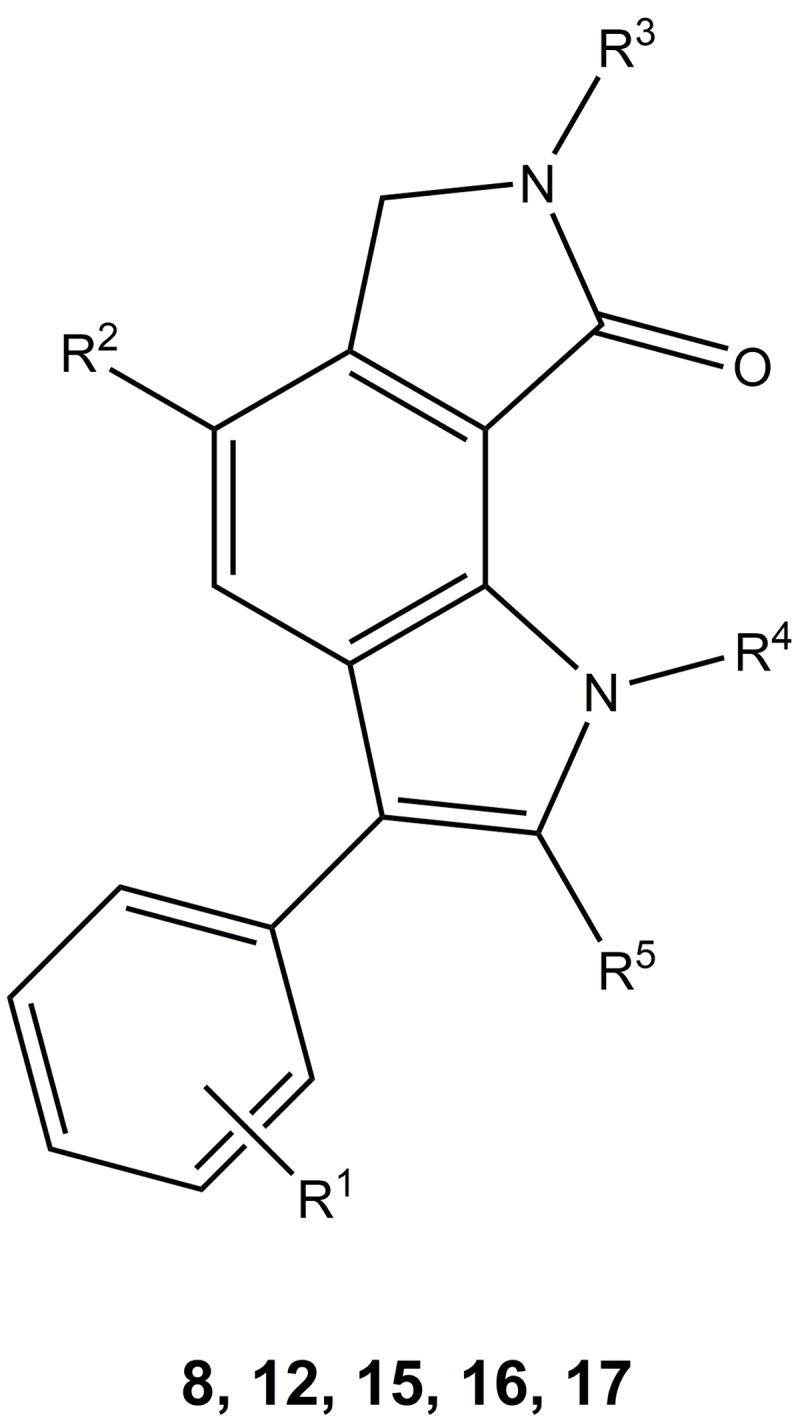
3-Aryl-6,7-dihydropyrrolo[3,4-g]indol-8(1H)-ones listed in Table 1.